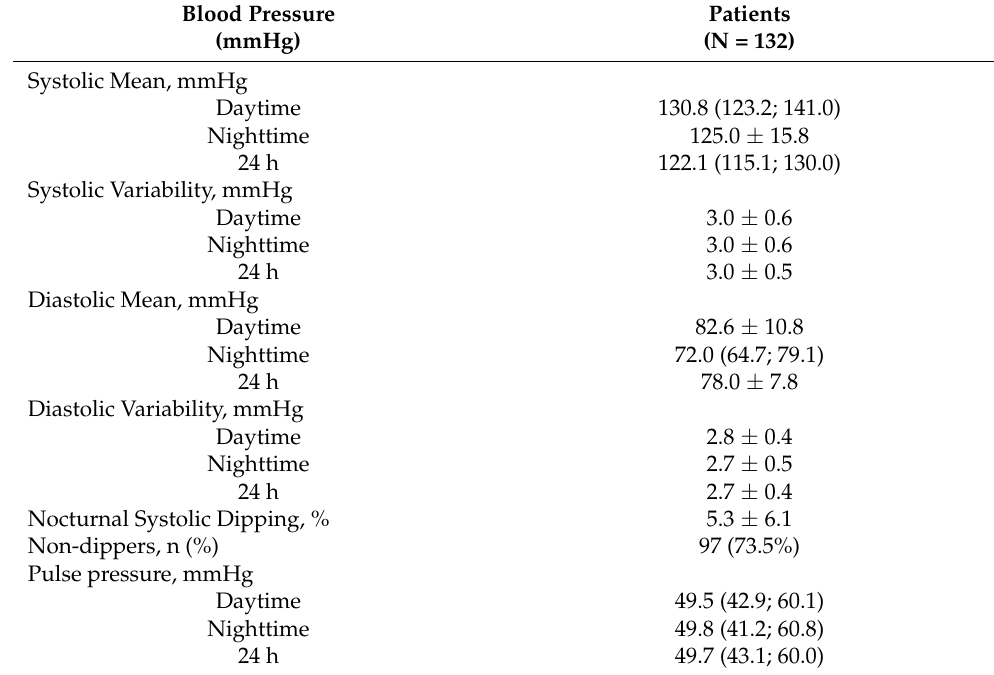
Table 2. 24 h ambulatory blood pressure